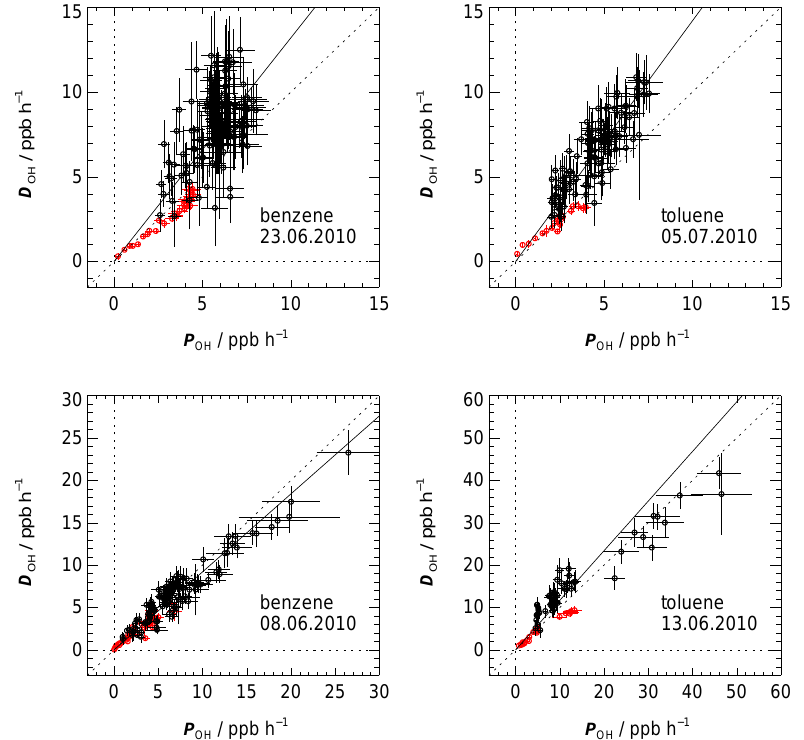
Figure 3. Correlation of OH destruction rates ( D OH ) and production rates ( P OH ) for SAPHIR experiments in 2010 under low-NO conditions (upper panels) and high-NO conditions (lower panels). Black and red data points indicate different periods of the experiments. Red: zero air period; Black: after the injection of aromatics. The solid lines correspond to the mean ratios listed in the third column of Table 3 ( P OH calculated by Eq. 2), dashed lines are 1:1